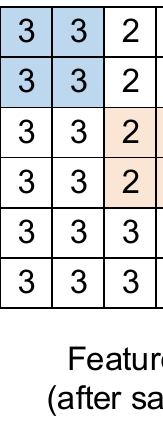
Figure 6. Diagram of operations performed by the upsampling layer.